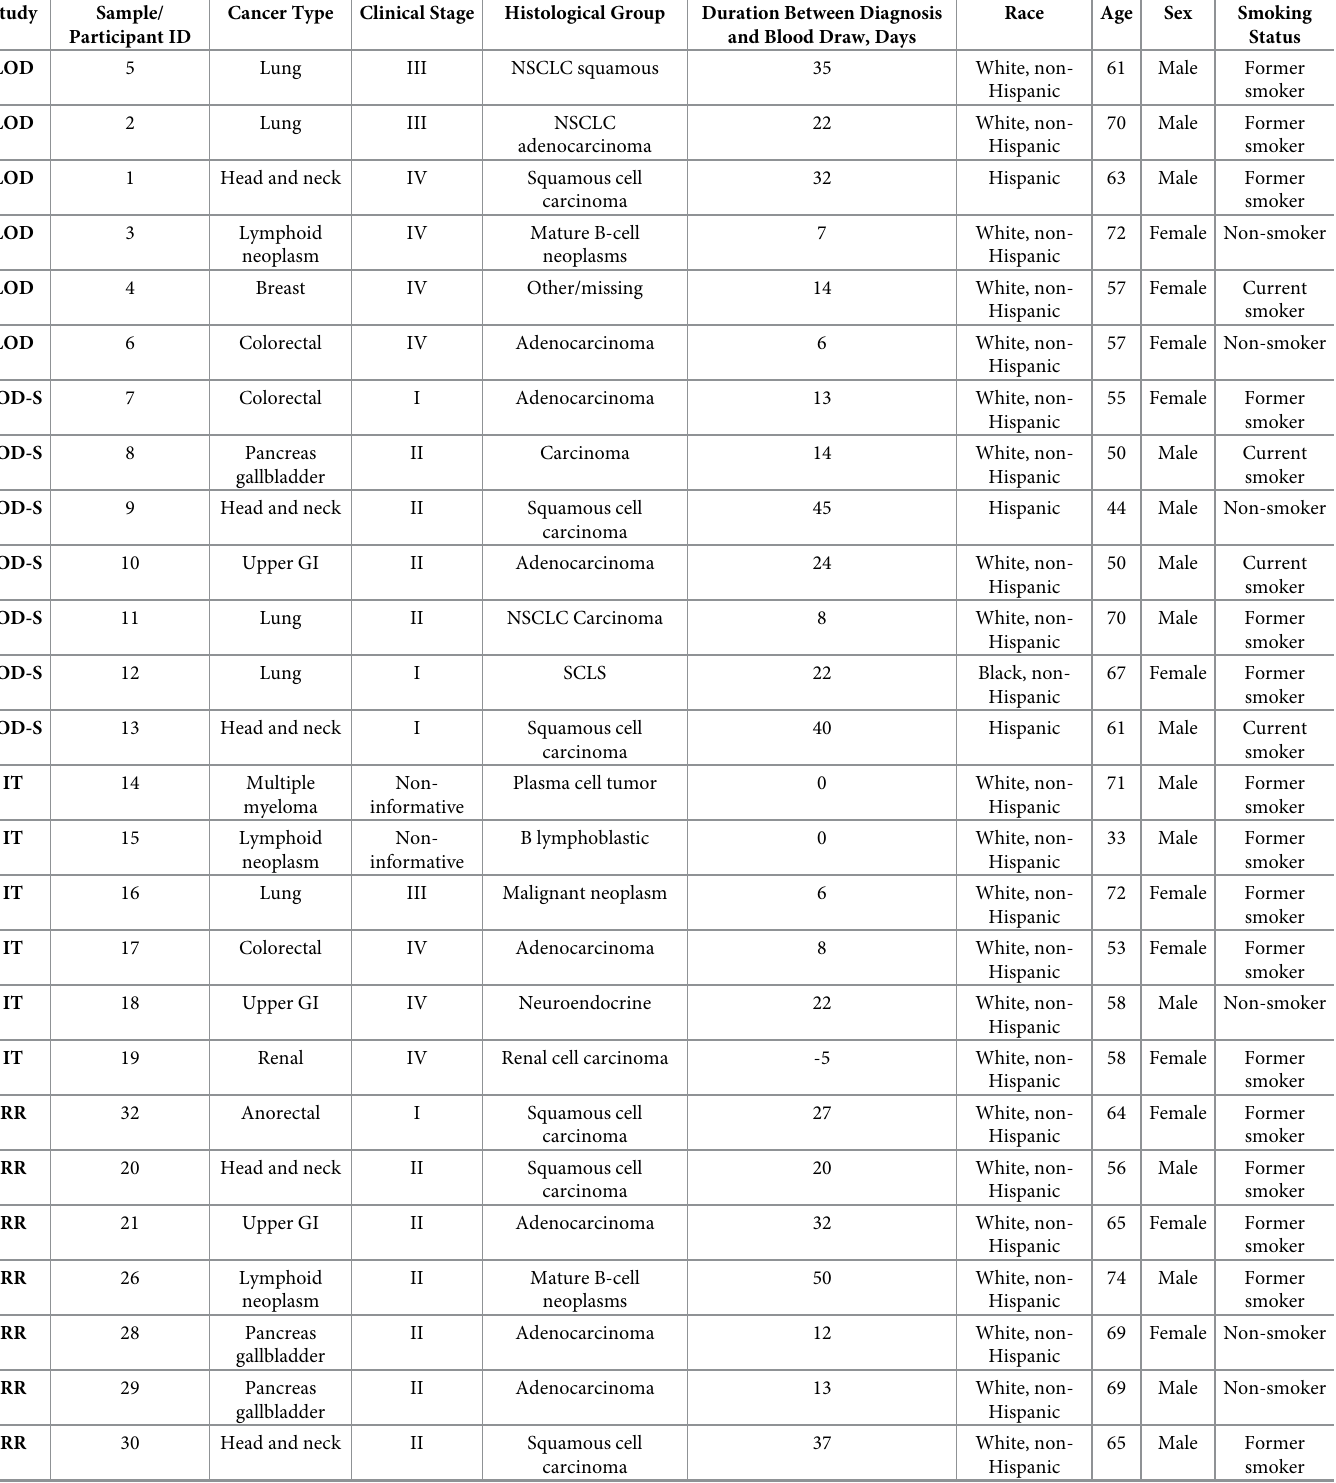
Table 1. Participant disposition by analytical validation